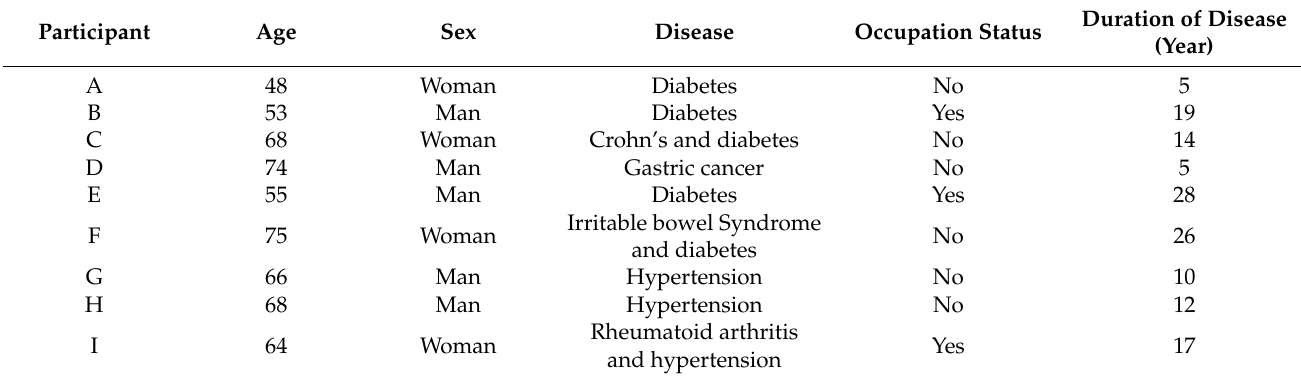
Table 2. General characteristics of